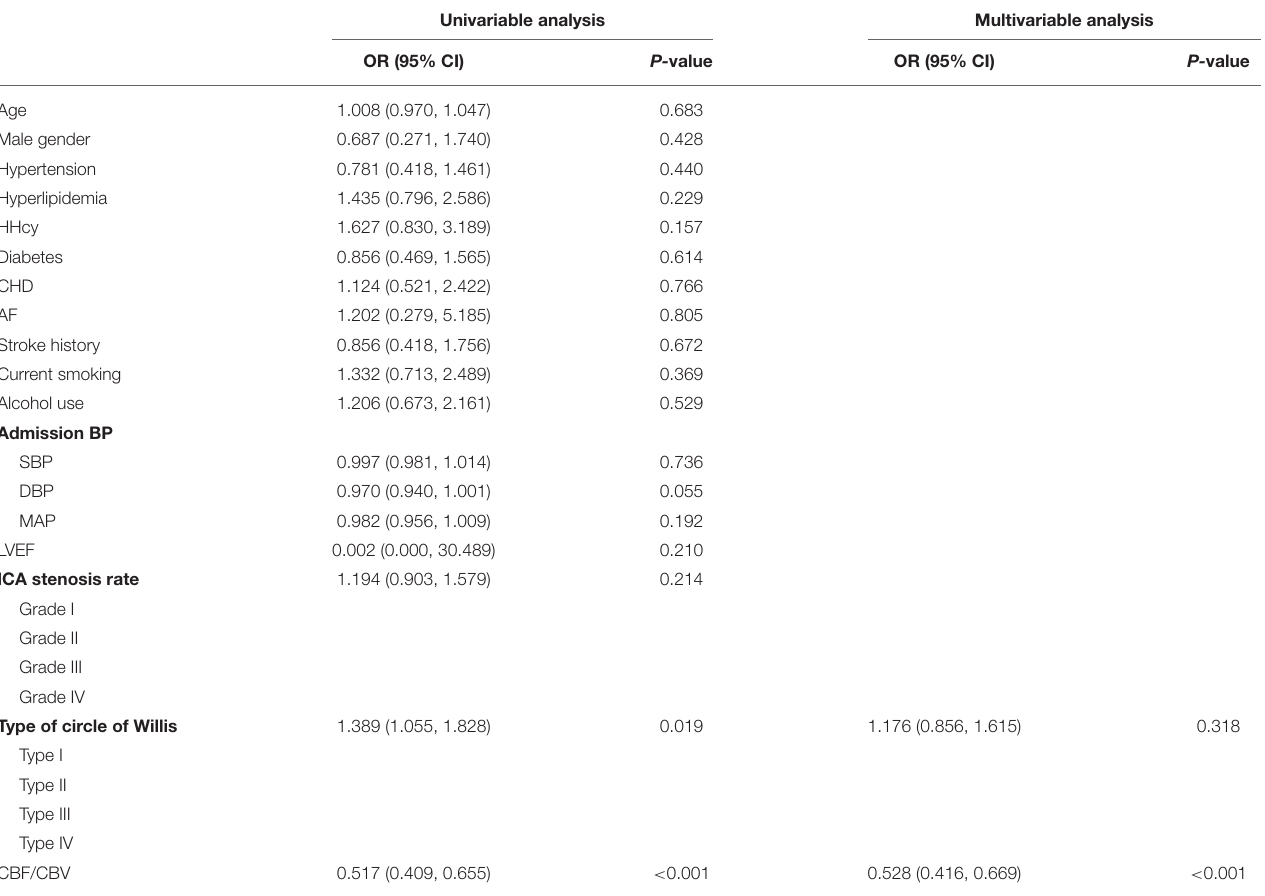
TABLE 5 | Univariate and multivariate analysis of factors associated with symptomatic